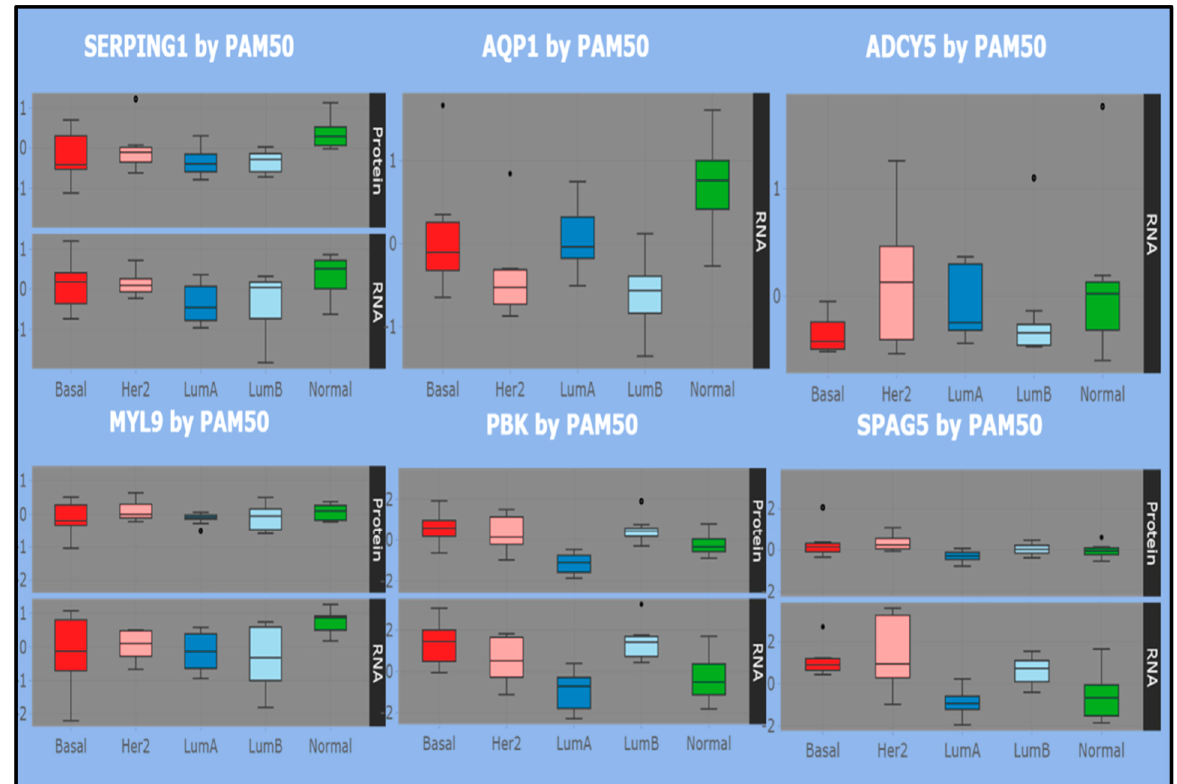
Figure 4. RNA–Protein correlations for some selected target genes/proteins (basal map top panel, luminal panel bottom panel). Boxplots of significant results. Average expression values reported in samples grouped by PAM50 subtypes. Source of the plots: https://www.breastcancerlandscape.org/, accessed on 23 November 2021.